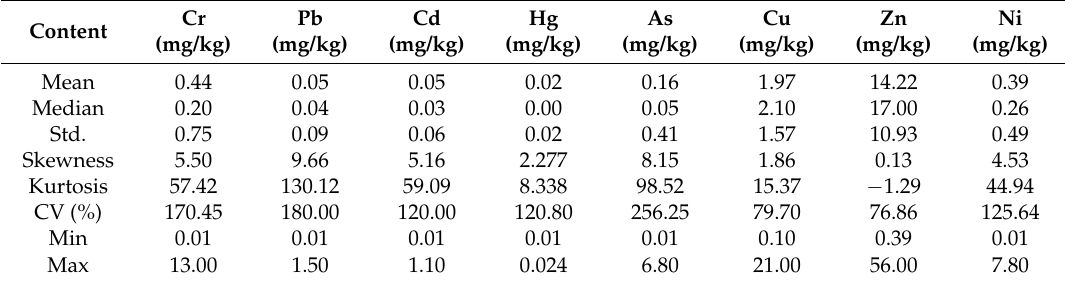
Table 5. Summary statistics of heavy metal contents in crops ( N = 1822).